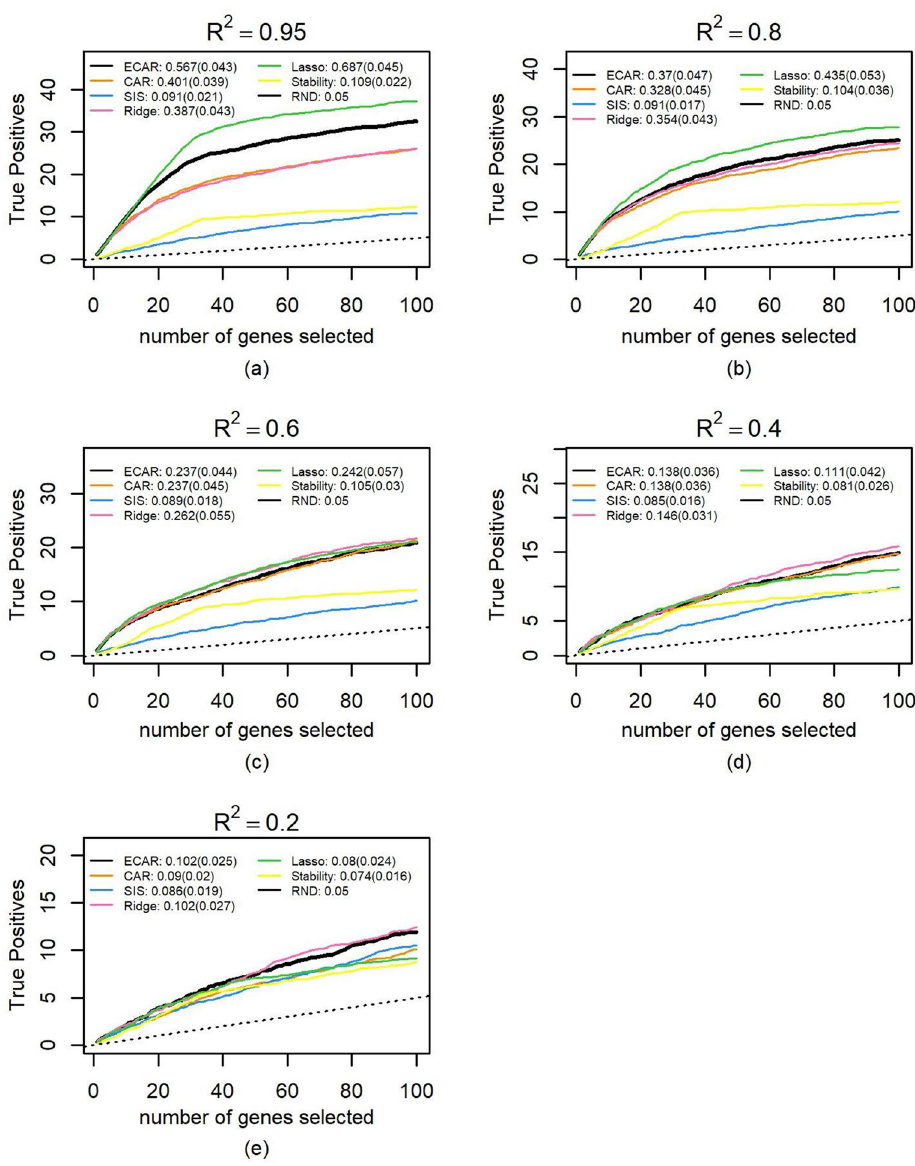
Figure 6. Comparison of variable selection performance on 500 semi-synthetic datasets. The median number of true positive variables as a function of the total number of selected genes as well as the median of PR-AUC and its standard deviation are shown for ECAR, CAR, SIS, ridge, lasso and stability selection under five R 2 scenarios. The total number of influential genes is 50, which are randomly selected from the 1000 genes. Parameter α of ECAR is estimated using the methods described in the Methods section. The regularization parameter of ridge and lasso is estimated using fivefold cross-validation and generalized cross-validation, respectively. As lasso cannot select more variables than the sample size, we let it choose genes randomly when all genes in the output selected set are chosen. ( a ) R 2 is controlled at 0.95 for the 100 simulated datasets. ( b ) Same as ( a ), R 2 controlled at 0.8. ( c ) Same as ( a ), R 2 controlled at 0.6. ( d ) Same as ( a ), R 2 controlled at 0.4. ( e ) Same as ( a ), R 2 controlled at